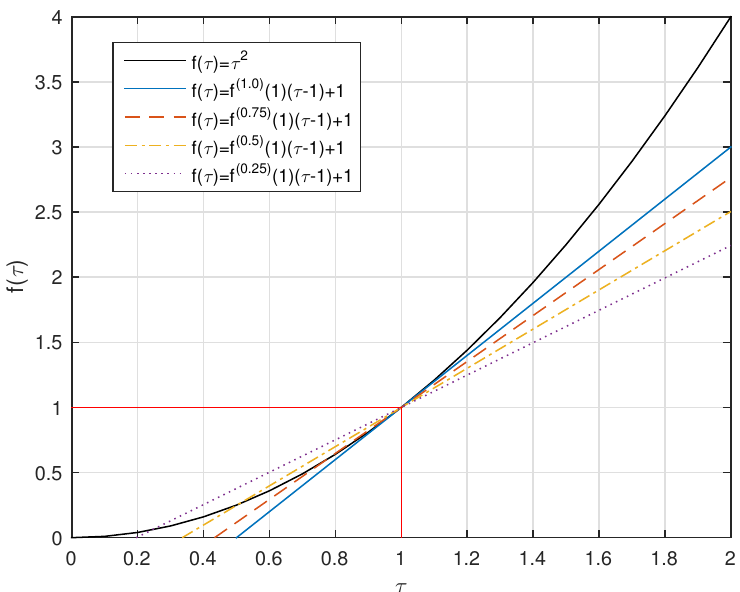
Figure 1. Plot of the function f ( τ ) = τ 2 with lines formed with fractional-order derivatives at the point P ( 1,1 )